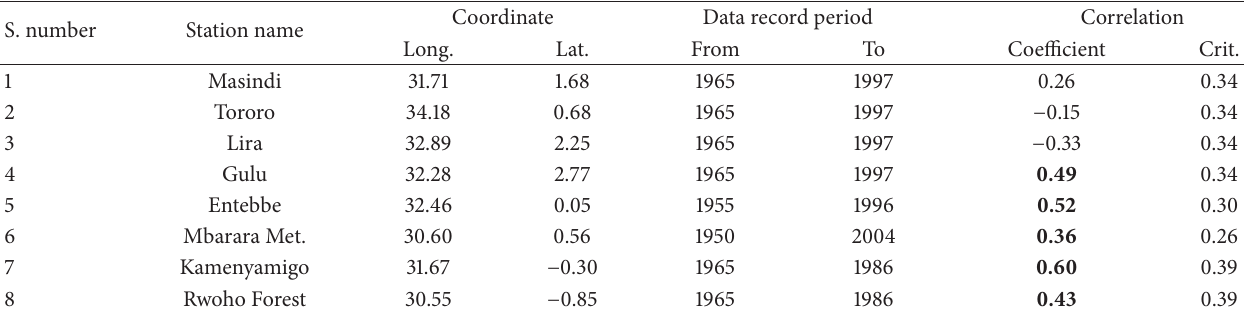
Table 1: Correlation between PGF-based series and observed rainfall at selected stations. S.